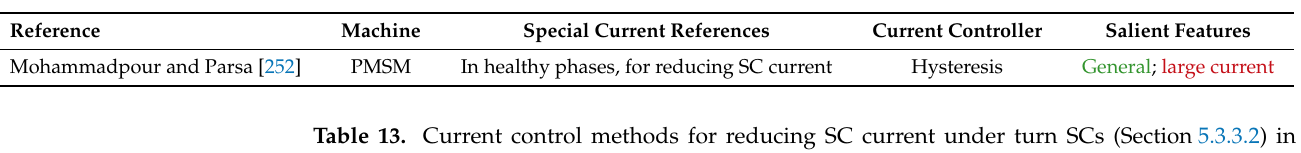
Table 12. Current control method for reducing SC current under phase SCs (Section 5.3.3.1) in multiphase applications in the literature.